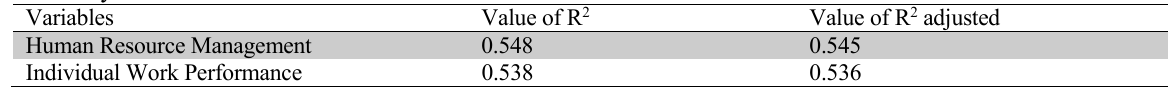
Summary coefficient of determination result